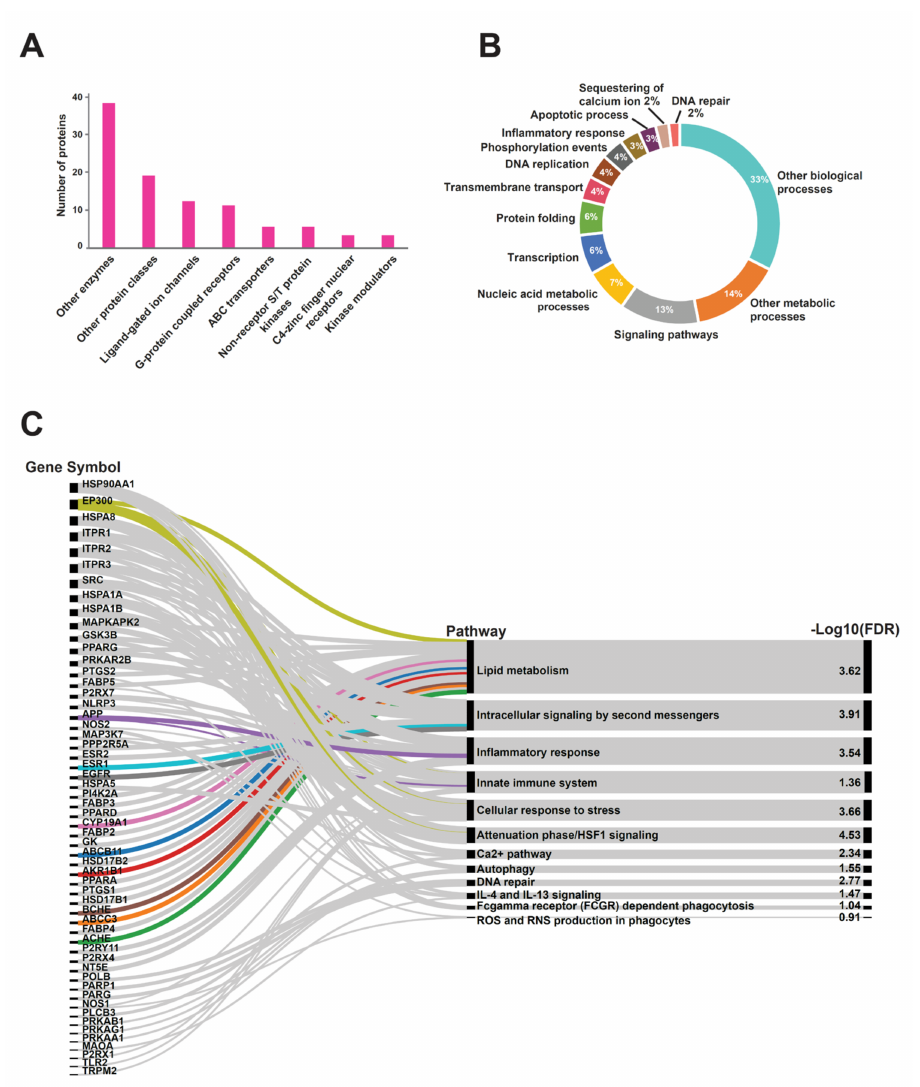
Figure 4. Gene Ontology classification of predicted protein targets—( A ) protein classes and ( B ) biological processes. ( C ) Pathway enrichment showed with an alluvial diagram. The thickness of the correlation lines connecting genes to pathways represents a significant p -value ( ≤